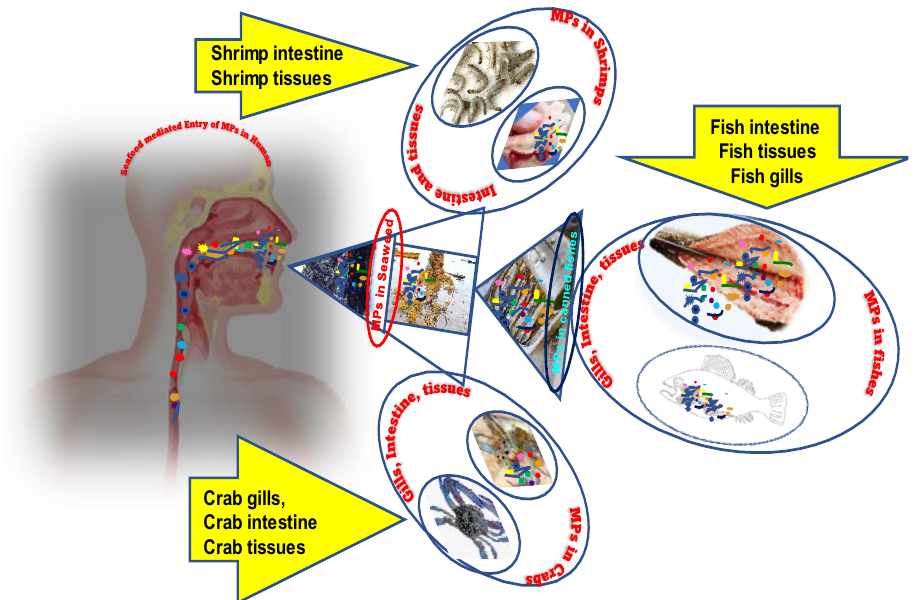
Figure 1. An overview of the various aquatic foods that are contaminated with MPs that have been discussed in the review. The pointers specify the actual locations where MPs are reported to be accumulated in fish, shrimp, and crabs, which enter the human body through MP-contaminated aquatic